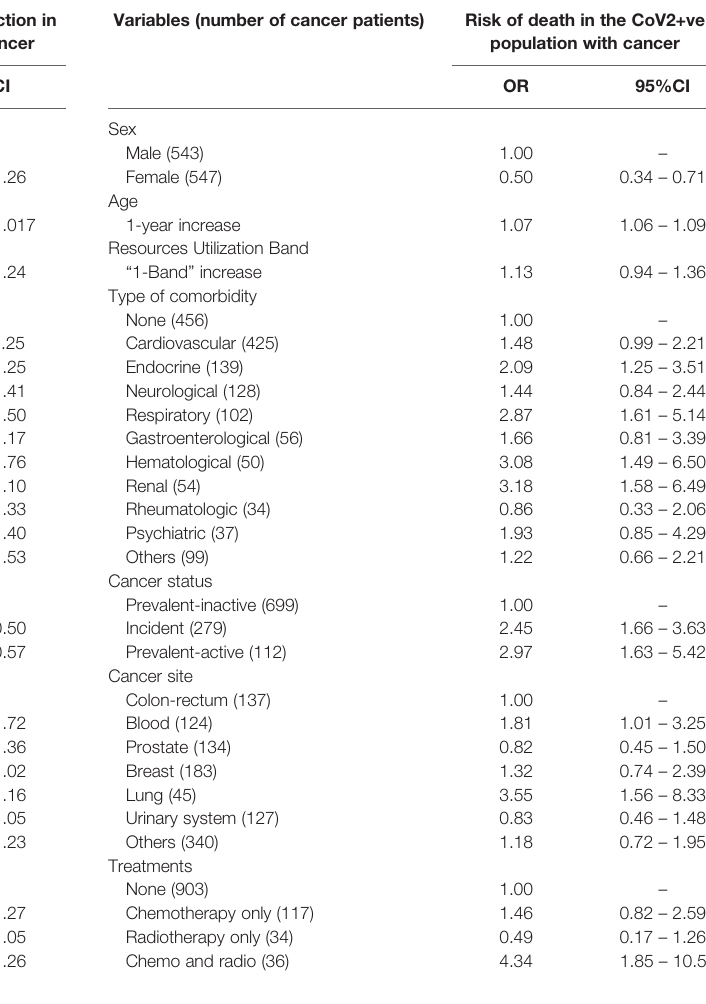
TABLE 2 | Risk of SARS-CoV-2 infection among cancer patients: multivariable logistic regression model. Variables (number of cancer patients) Risk of SARS-CoV-2 infection in